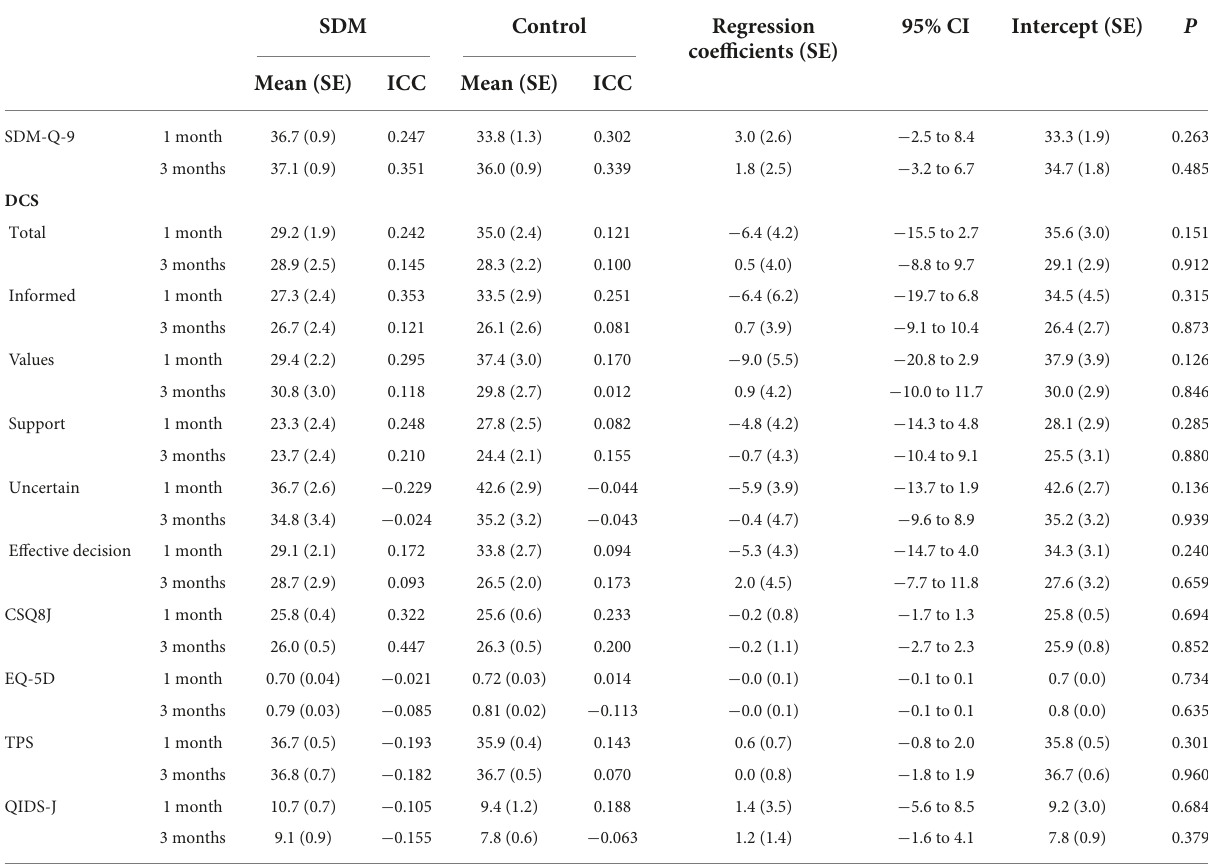
TABLE 4 Comparison of outcomes at the time of first and third month follow-ups. SDM